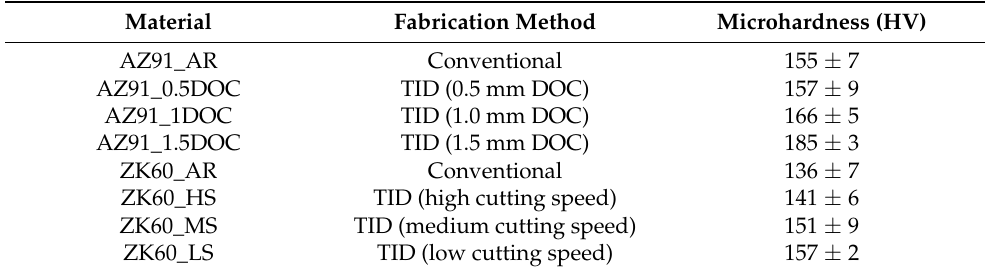
Table 5. Average microhardness of Mg materials undergoing both conventional and TID method processing [18,25].